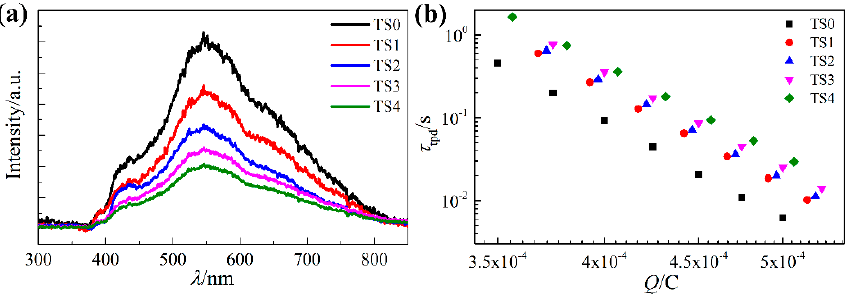
Figure 7. ( a ) Photoluminescence (PL) spectra of the pure TiO 2 NWAs (TS0) and Sn-doped TiO 2 NWAs (TS1, TS2, TS3, TS4), ( b ) Plots of lifetime of photoinjected electrons in the DSSCs based on the pure TiO 2 NWAs (TS0) and Sn-doped TiO 2 NWAs (TS1, TS2, TS3, TS4) as a function of charge.